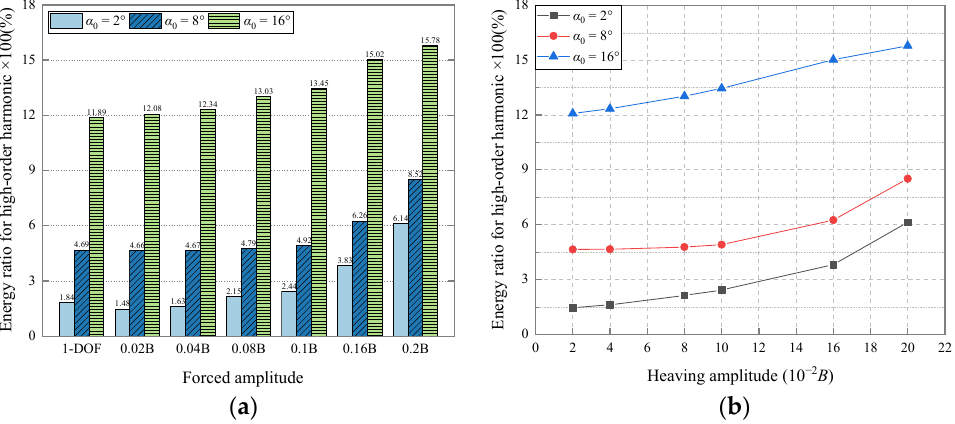
Figure 19. Proportion variation in high-order harmonic components of aerodynamic moment with different heaving amplitudes. ( a ) Comparison of 1-DOF pitching motion with 2-DOF coupled motion; ( b ) 2-DOF coupled motion.